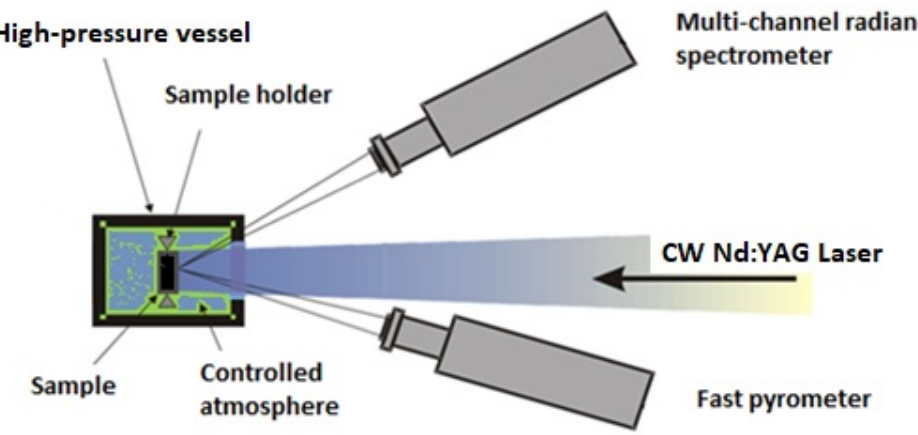
Figure 1. Schematic of the laser-heating set-up employed in this